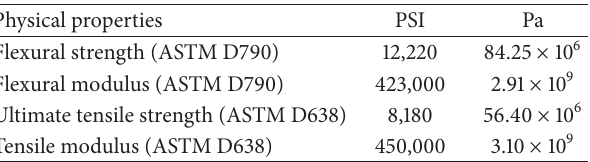
Table 2: Physical properties of combination of EpoxAmite 100 and 102 hardener.